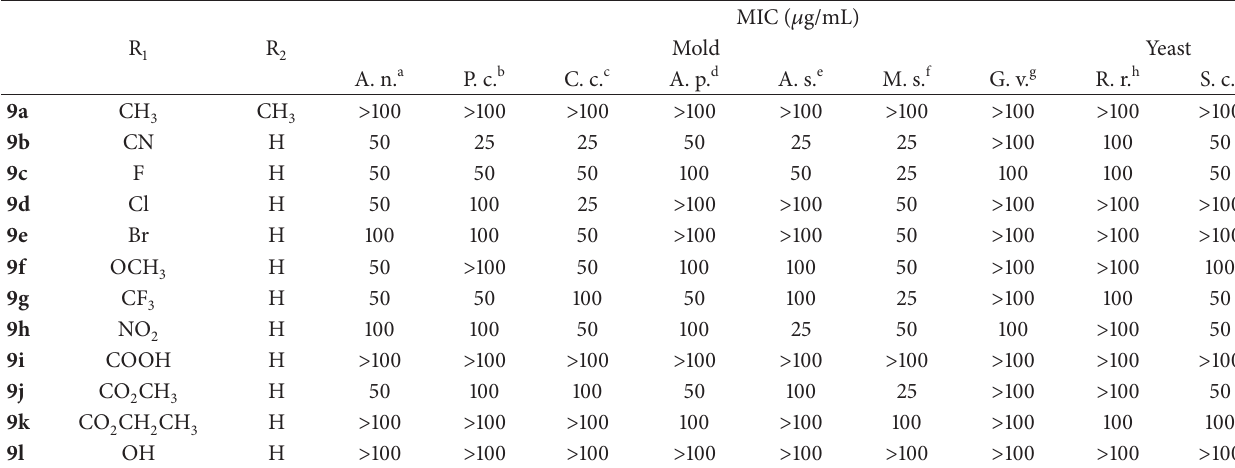
Table 3: Antifungal activities of compounds 9a – l .